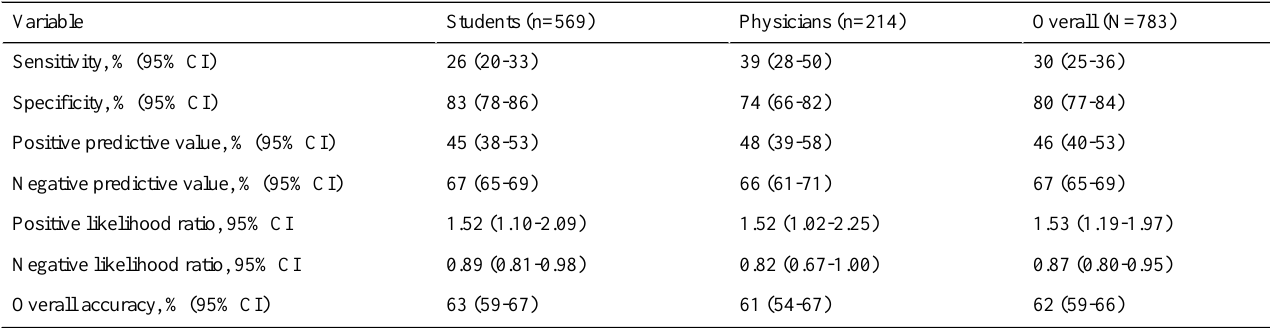
Table 3. Accuracy, sensitivity, specificity, predictive values, and likelihood ratios for students’and